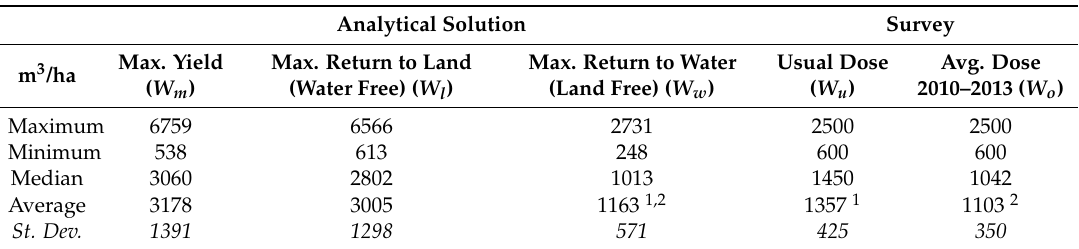
Table 3. Solutions to the microeconomic model and observed behavior. Analytical Solution